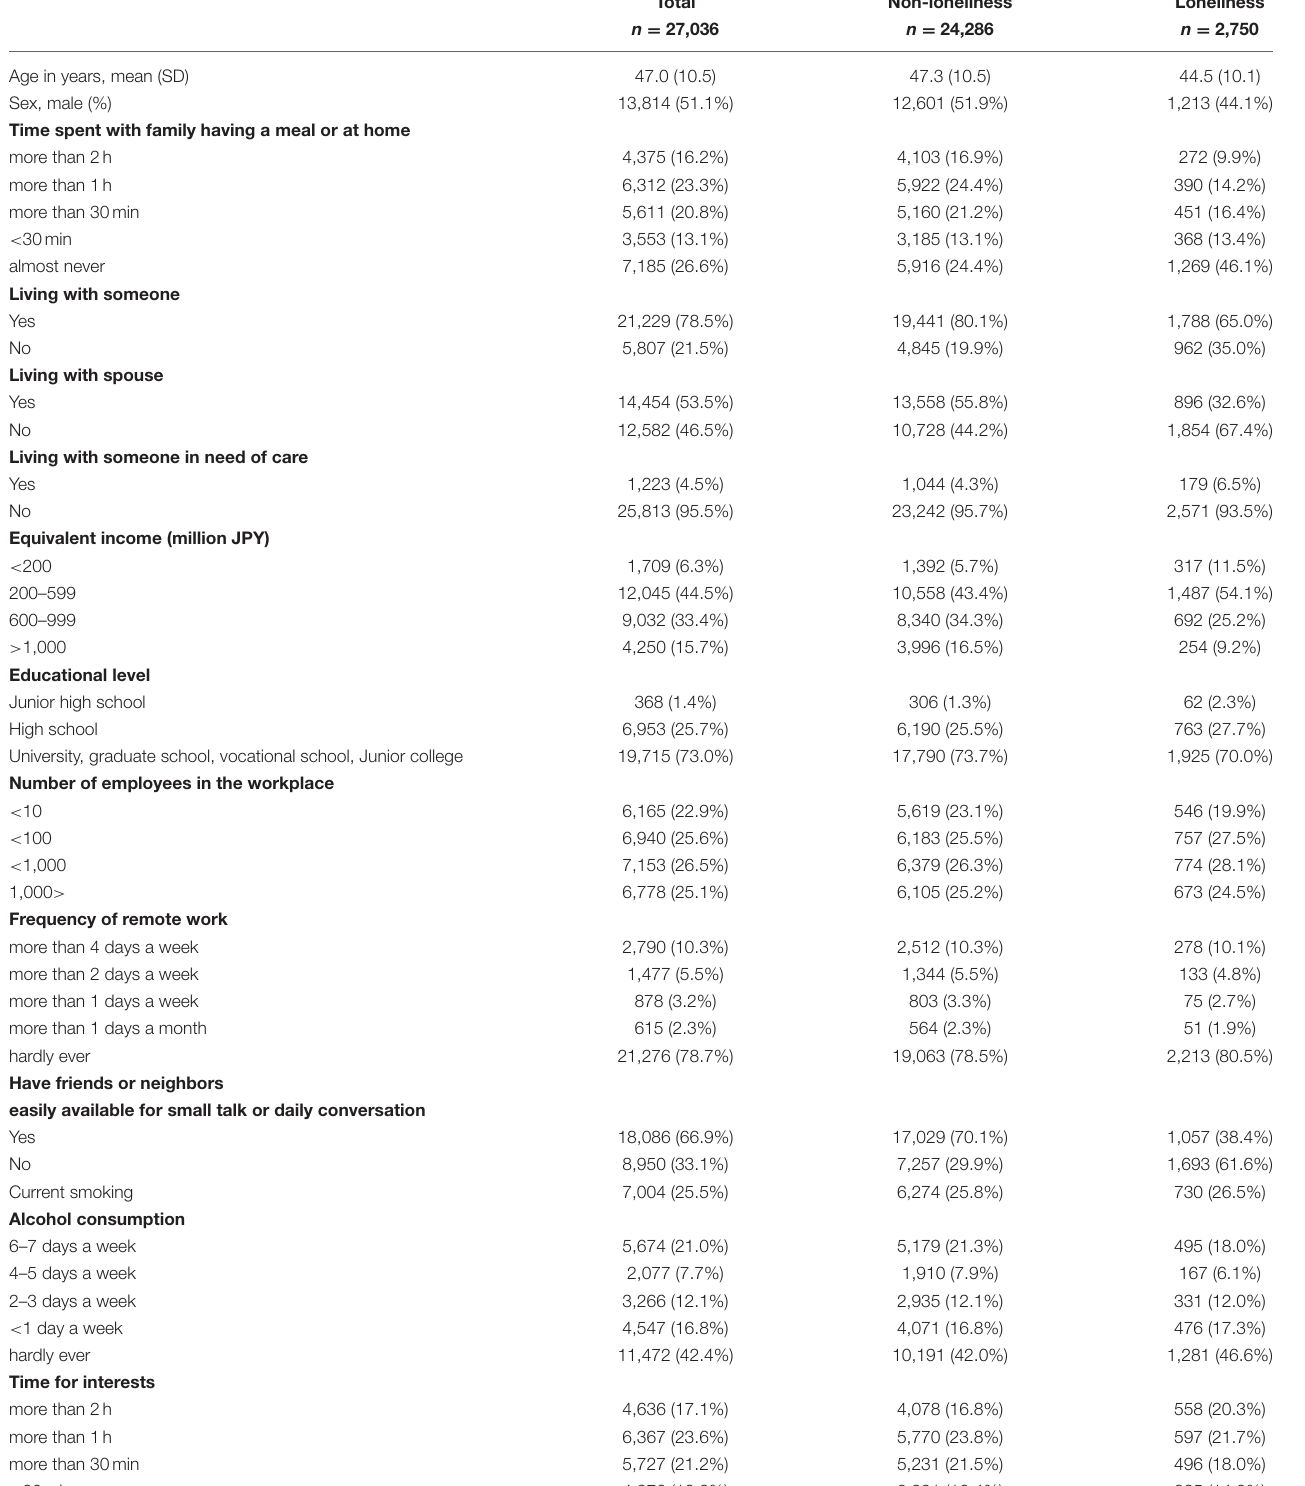
TABLE 1 | Characteristics of participants who experienced loneliness.